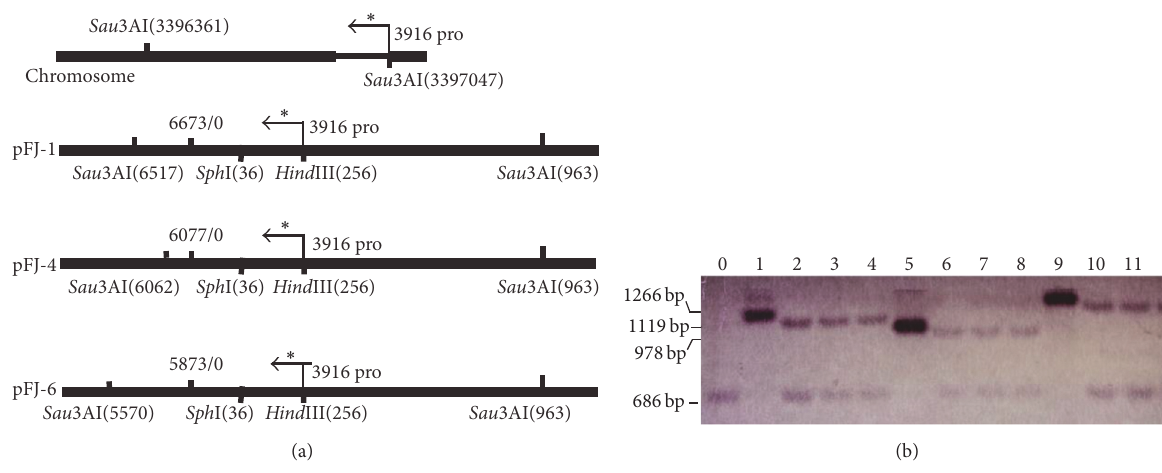
Figure5:RelativecopynumbersofthepFJ1,pFJ4,andpFJ6plasmidsinJ7-Fcells.(a)SchematicdiagramsoftheJ7chromosomeandindicated vectors. The specific locations of Sau 3AI sites in the J7 chromosome and plasmids are shown. The 200 bp 3916 pro segment, which was used as a DIG-labeled probe, is indicated with arrows and asterisks. (b) The copy numbers of pFJ1-pro3916, pFJ4-pro3916, and pFJ6-pro3916 were determined by Southern blot analysis. Sau 3AI-digested total DNA from J7-F cells transformed with pFJ1 (lanes 2–4), pFJ4 (lanes 6–8), or pFJ6 (lanes 10–12) was hybridized with the DIG-labeled 3916 pro sequence. Total DNA samples from J7-F cells (lane 0), pFJ1-pro3916 (lane 1), pFJ4-pro3916 (lane 5), and pFJ6-pro3916 (lane 9) plasmids propagated in E. coli were used as